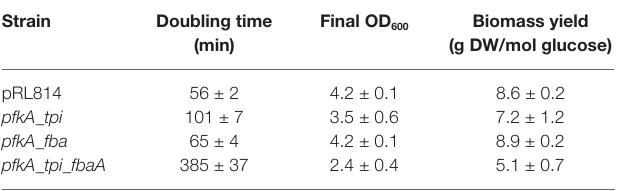
Strains were grown on microtiter plates until stationary phase (50 h), as described in Figure 3 . Doubling times were calculated from growth curves using the package “growthcurver” in R (Sprouffske and Wagner, 2016). Final OD 600 of pooled triplicates of each culture were determined by spectrophotometer. Spent bacterial samples at time 0 and 50 h were analyzed by HPLC to determine glucose consumption. Biomass yield was calculated as increase in dry weight (DW) per glucose used. Each average and standard deviation is calculated from at least three biological